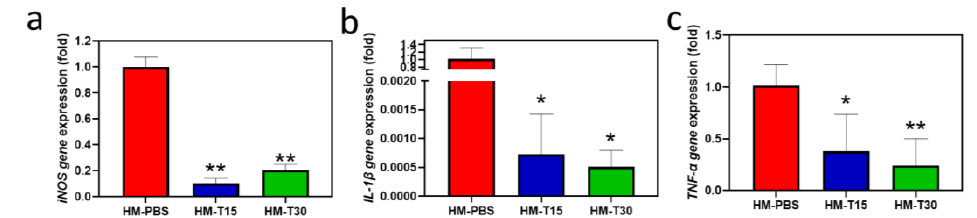
Figure 8. Gene expression of pro-inflammatory cytokines ( a ) iNOS , ( b ) IL- 1β , and ( c ) TNF- α in L-929 cells after 72 h. One-way ANOVA, * p < 0.05, and ** p < 0.01 compared with the HM group.